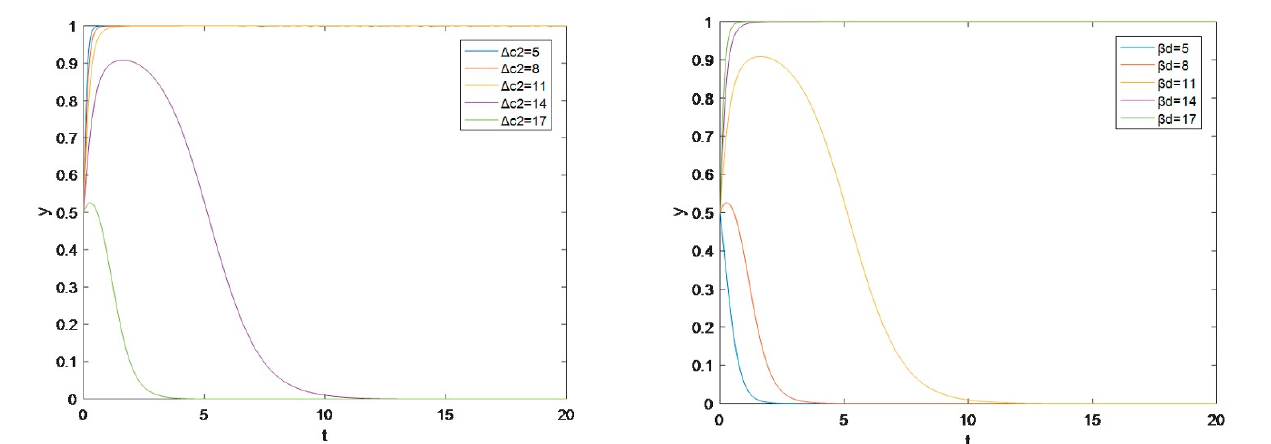
(b) The impact of accountability or punishment on local government’s strategies. Figure 15. The impact of both the benefit from rent-seeking behaviors and accountability or punish- ment on local government’s strategies.